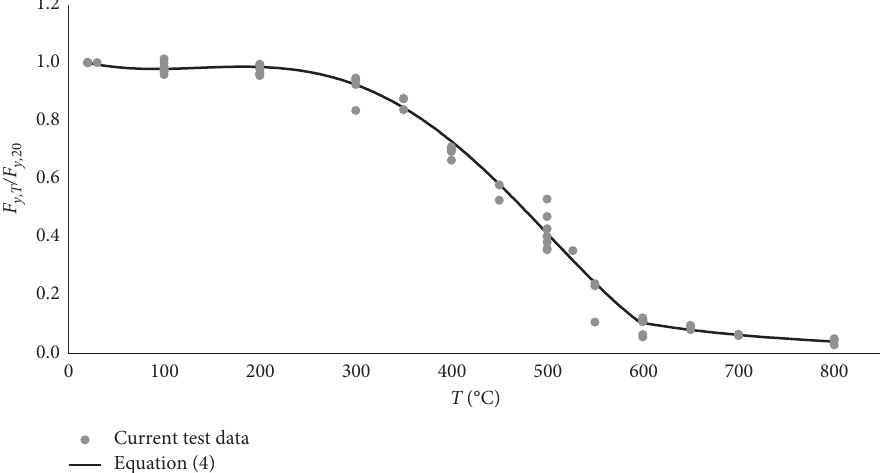
Figure 23: Fitting curve of the retention factors for yield strength of stress relieving annealed steels.